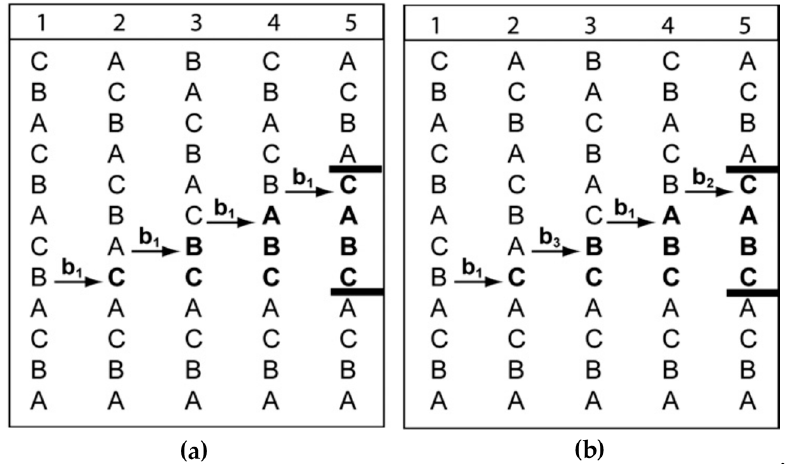
Figure 10. The step-by-step process of producing a four-layer deformation twin by the slip of ( a ) identical and ( b ) different partial dislocations on successive slip planes